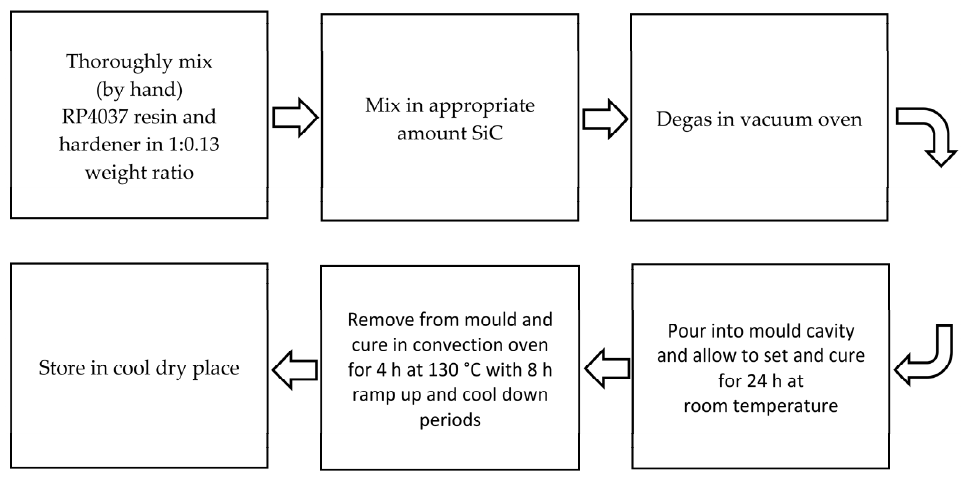
Figure 4. Procedure for tooling board preparation [136].